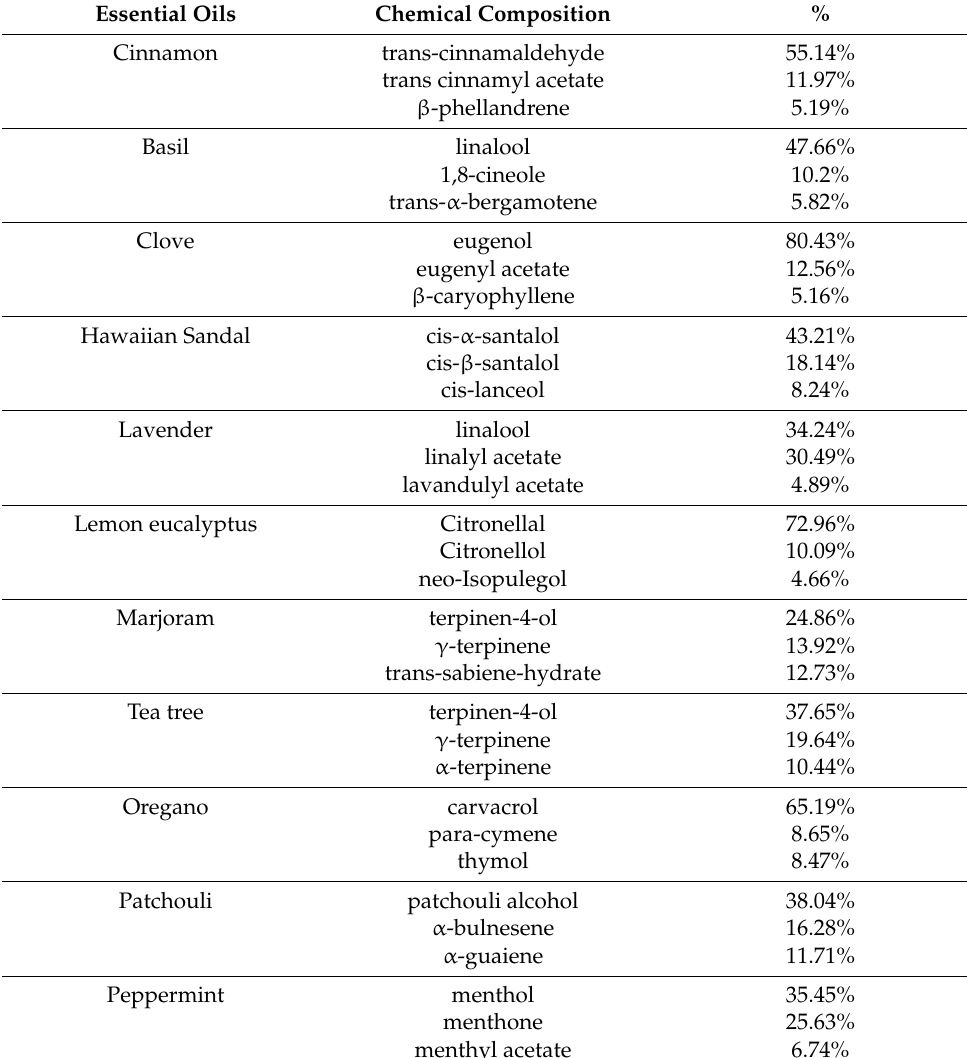
Table 1. The main chemical compounds described in the tested